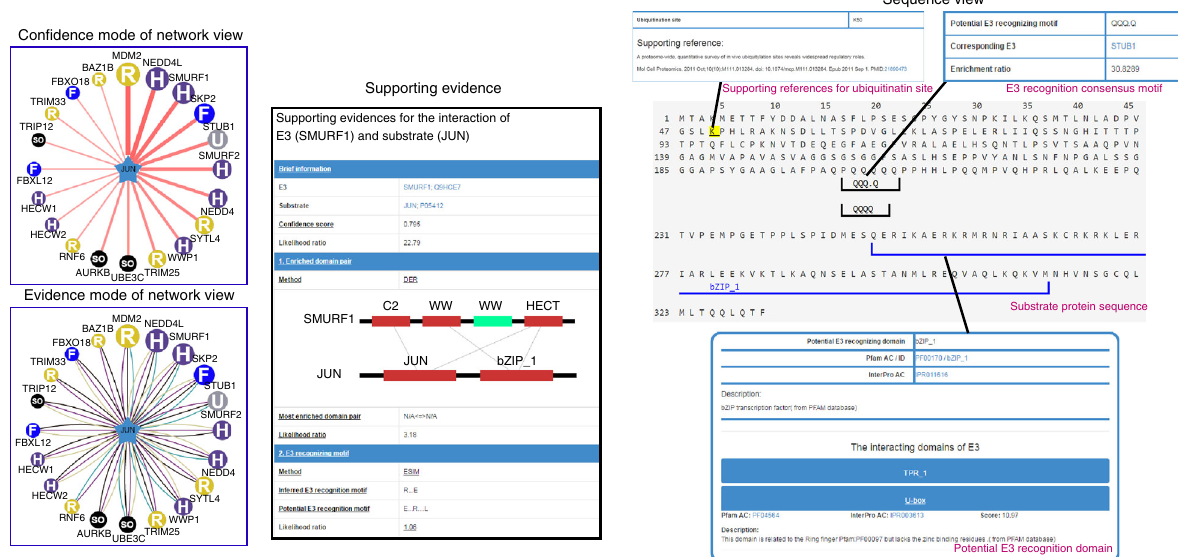
Fig. 5 Network and sequence view for predicted E3-substrate interactions in UbiBrowser web services. In network view the central node is the queried E3 ligase or substrate, and the surrounding nodes are the predicted substrates or corresponding E3s. In the con fi dence mode of network view, the edge width and surrounding node size are positively correlated with the con fi dence of prediction, and in the evidence mode of network view, each E3-substrate interaction will be presented by multiple lines with different colors for different type of evidence. Clicking each edge will lead to a popup illustrating the supporting evidence, and clicking the surrounded node a popup for the sequence view of the involved substrate. In the sequence view for each E3-substrate interaction, the substrate ’ s sequence is shown in PRIDE format with multiple signs: black lines under the sequence denote the potential domain interacting with related E3, gray lines under the sequence mark the inferred E3 recognition consensus motif and the yellow background of character K means